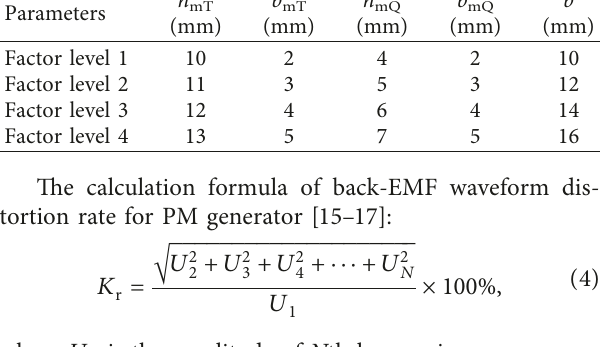
Table 2: Test table of optimization parameters and factor level.